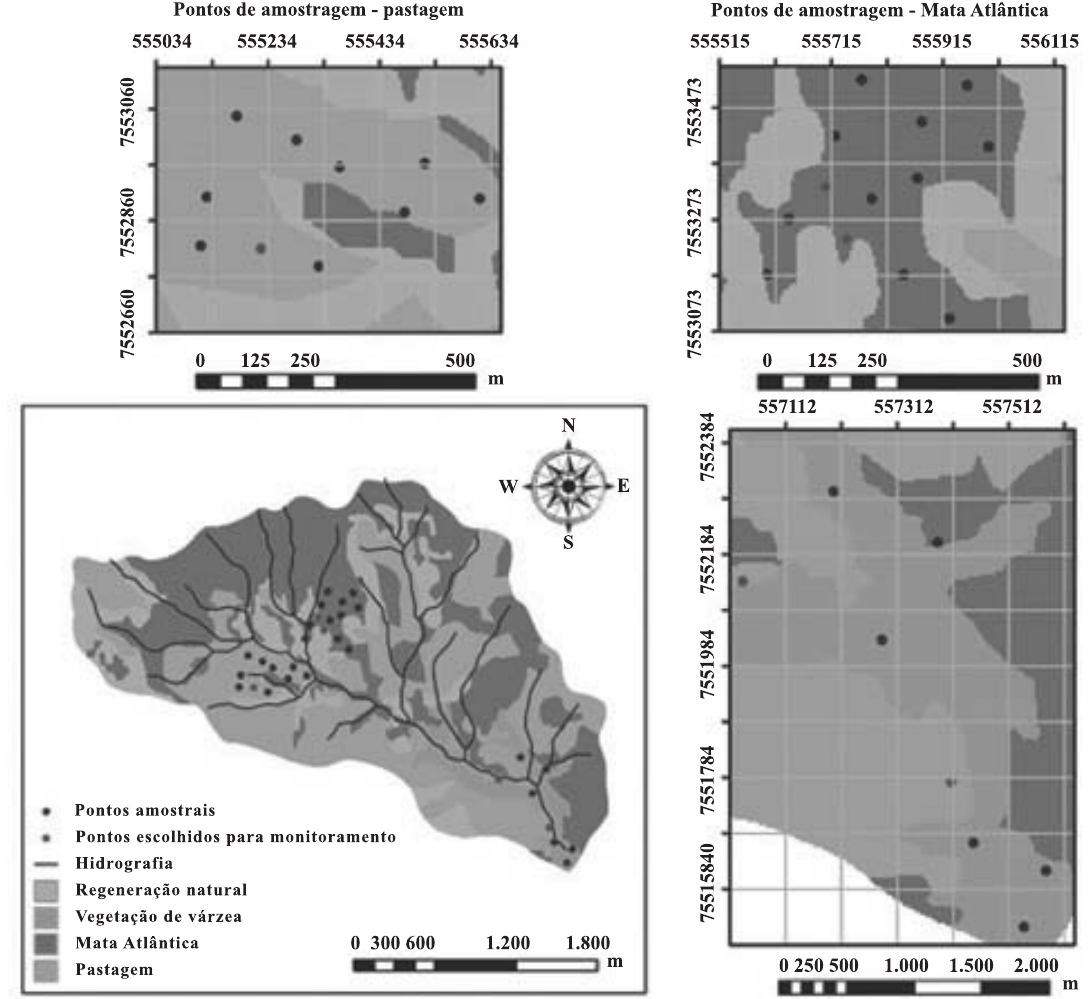
Figura 2. Distribuição espacial do uso atual do solo e localização dos pontos amostrais e de monitoramento da umidade do solo na bacia hidrográfica experimental do ribeirão Lavrinha, Serra da Mantiqueira, Minas